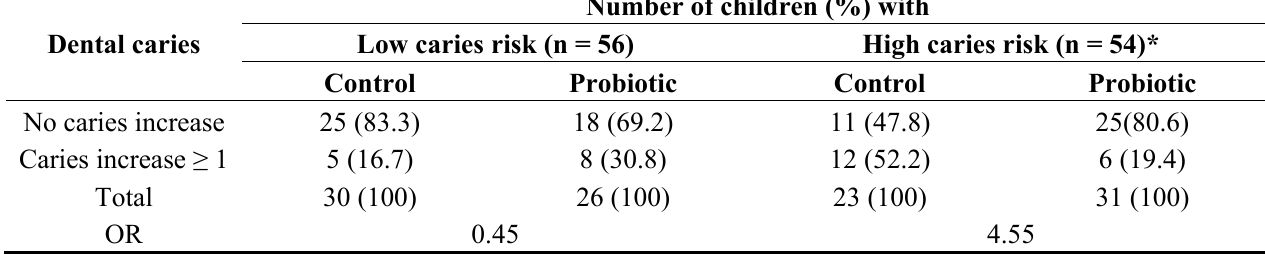
Table 3. Number of children with caries increments of the control and probiotic groups with low and high caries